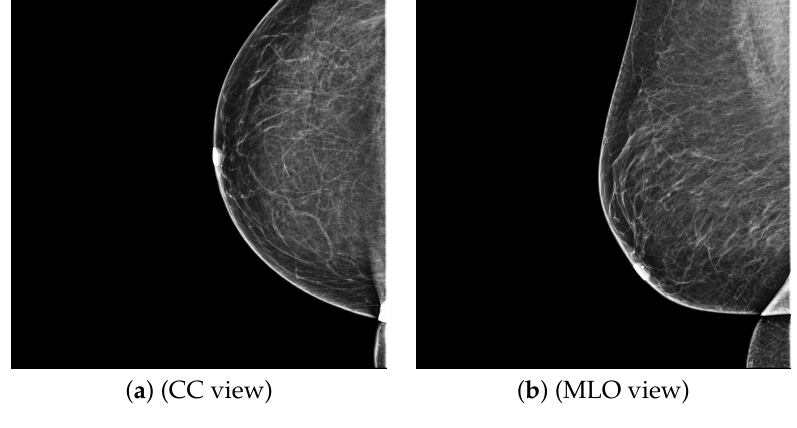
Figure 1. FFDM view for right breast.